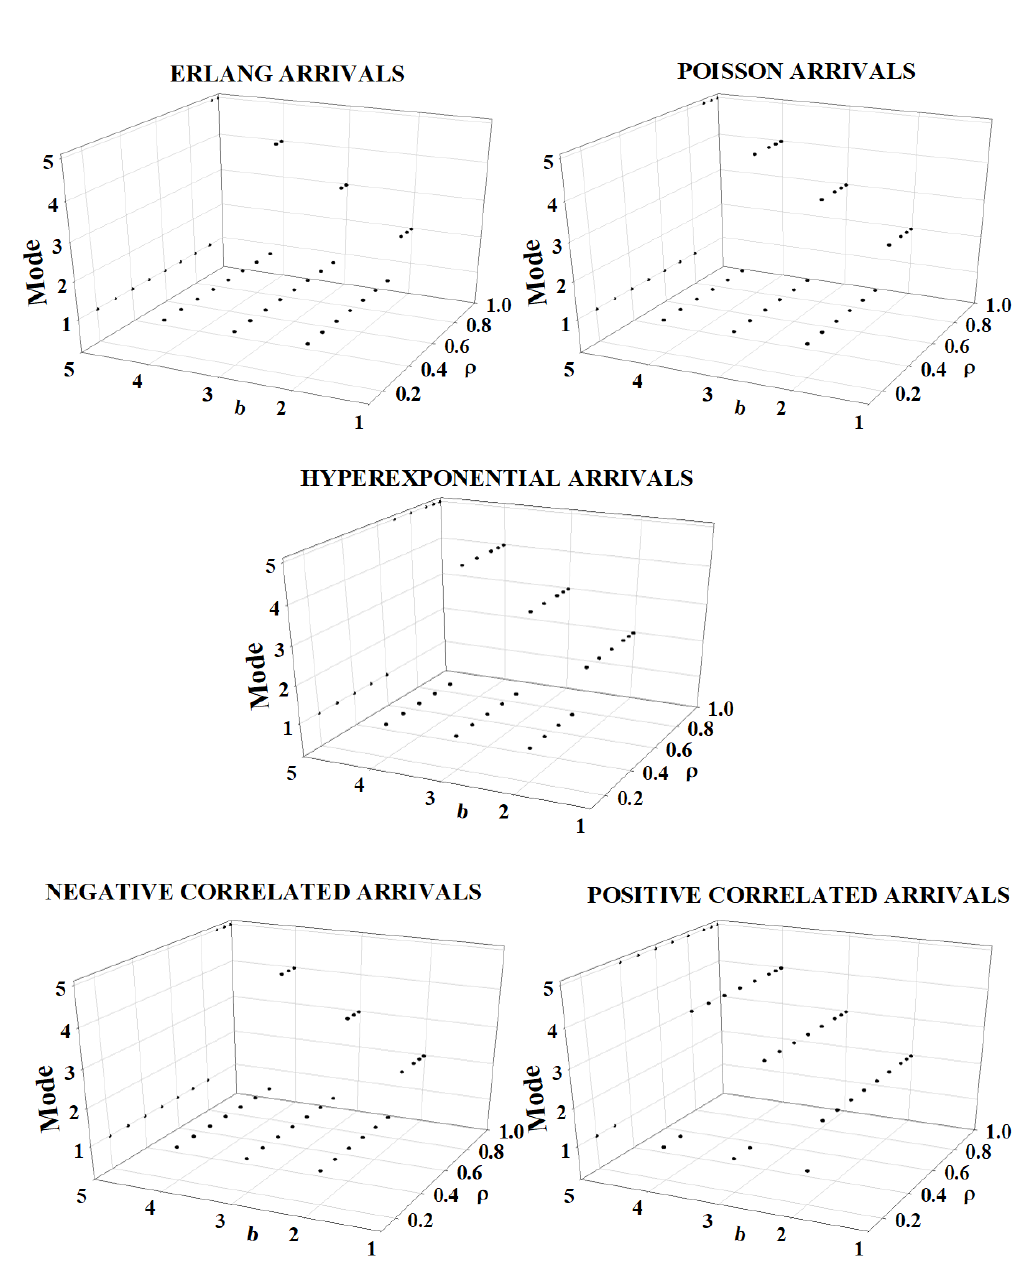
Figure 6. Scatter plot of the mode of the conditional PMF of the number in service for example